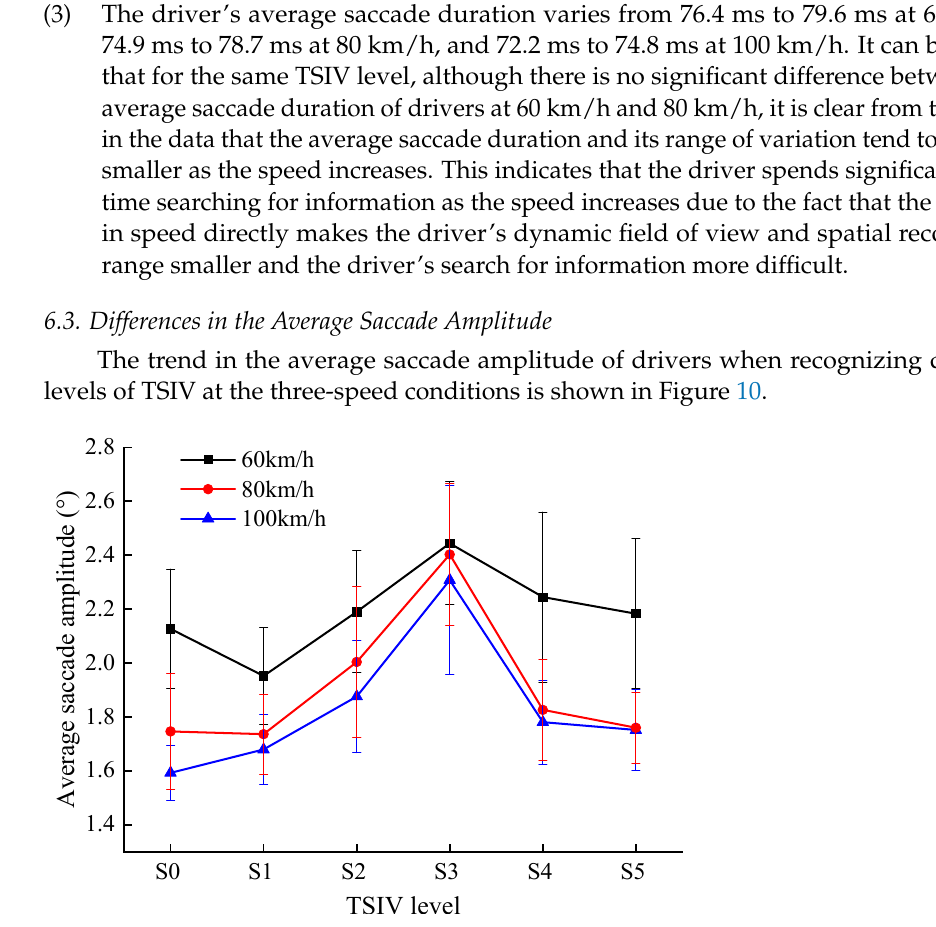
Figure 10. The comparison of average saccade amplitude for each TSIV at the three